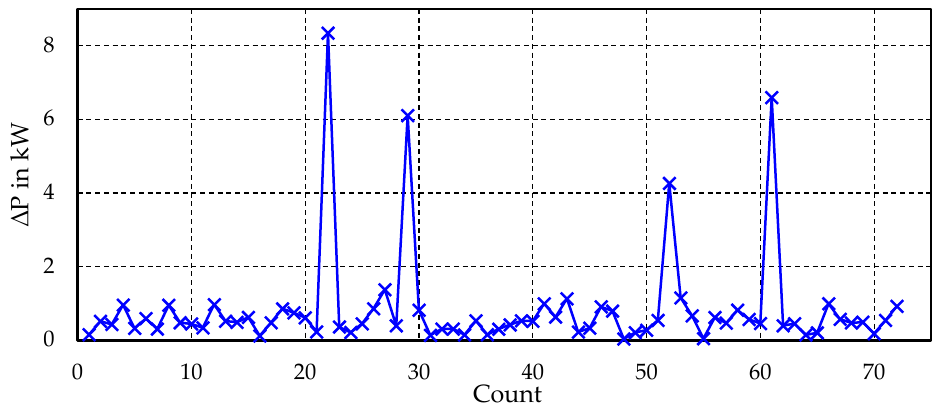
Figure 7. Line plot of outliers.